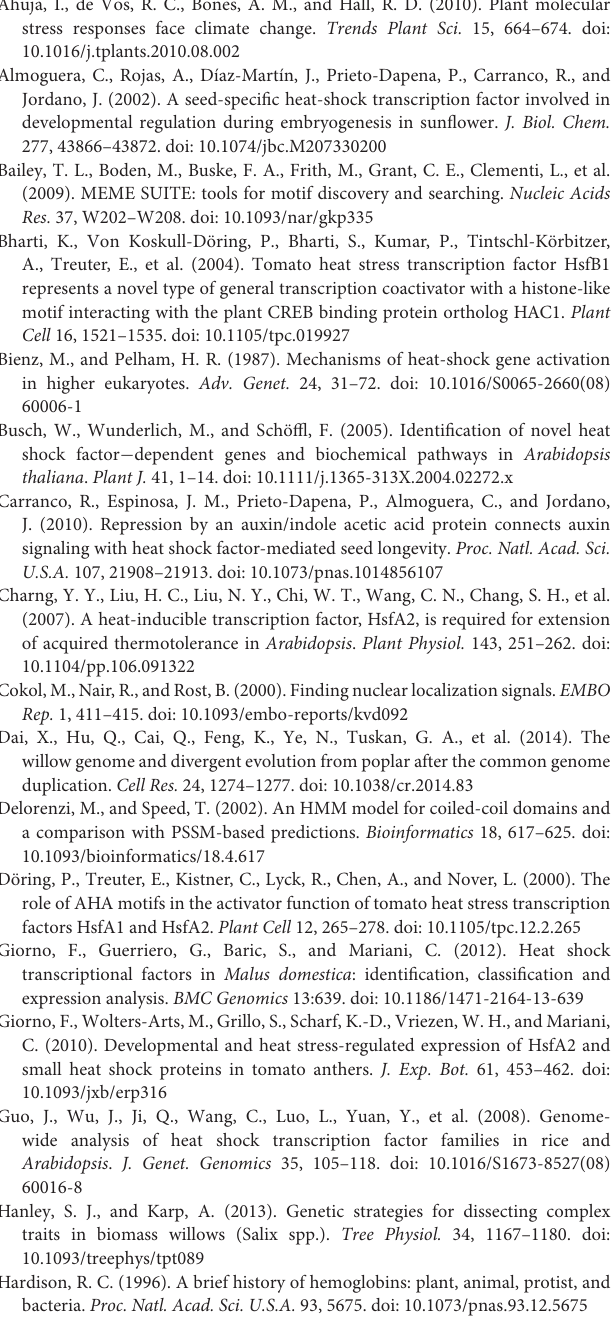
control (0h). Data represent the average of three independent experiments ± SE. Figure S1 | Sequence identity of Hsf proteins in S. suchowensis , P. trichocarpa , and A. thaliana . Amino acid identity among Hsf proteins was analyzed in pairwise